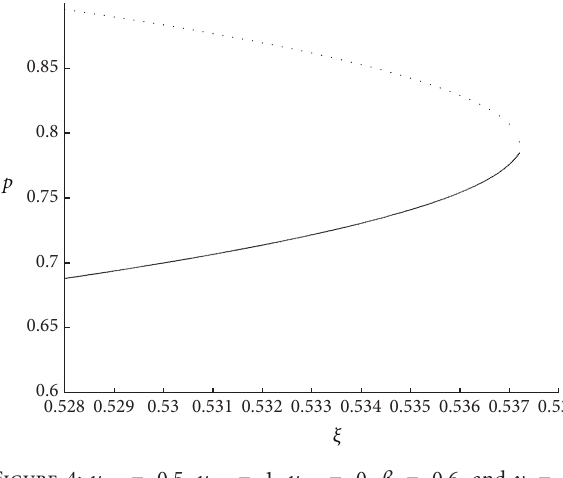
Figure 4: 𝑢 11 = 0.5 , 𝑢 12 = 1 , 𝑢 22 = 0 , 𝛽 = 0.6 , and 𝛾 = 10 . A saddle-node bifurcation happens for (𝑝 ∗ , 𝐹 ∗ ,𝜉 ∗ ) , where 𝑝 ∗ = 0.7916666665, 𝐹 ∗ = 0.4285714286, and 𝜉 ∗ = 0.5372023808 . Two new polymorphic phenotypic equilibria are created for 𝜉 < 𝜉 ∗ and disappear for 𝜉 > 𝜉 ∗